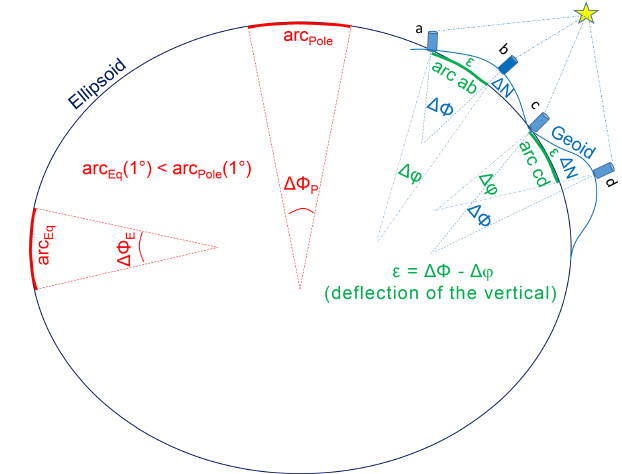
Figure 2. Determination of the flattening of the ellipsoid (left) and the varying curvature of the meridian (right) from astronomic ( (cid:49)(cid:56) ) and geodetic (ellipsoidal (cid:49)ϕ ) meridian arc measurements showing different deflections of the vertical ε and geoid heights N